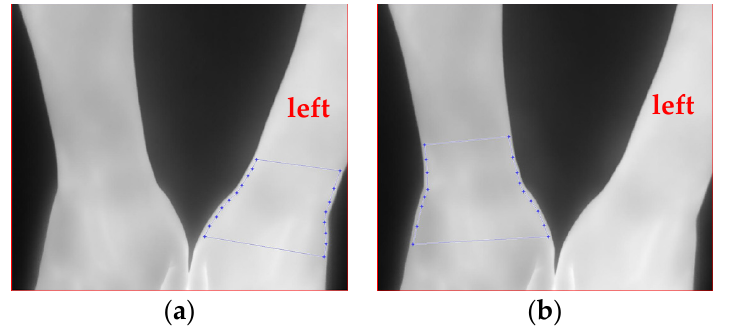
Figure 2. IR thermal images indicating the region of interest as a dotted line: ( a ) fractured left wrist; ( b ) contralateral uninjured right wrist.